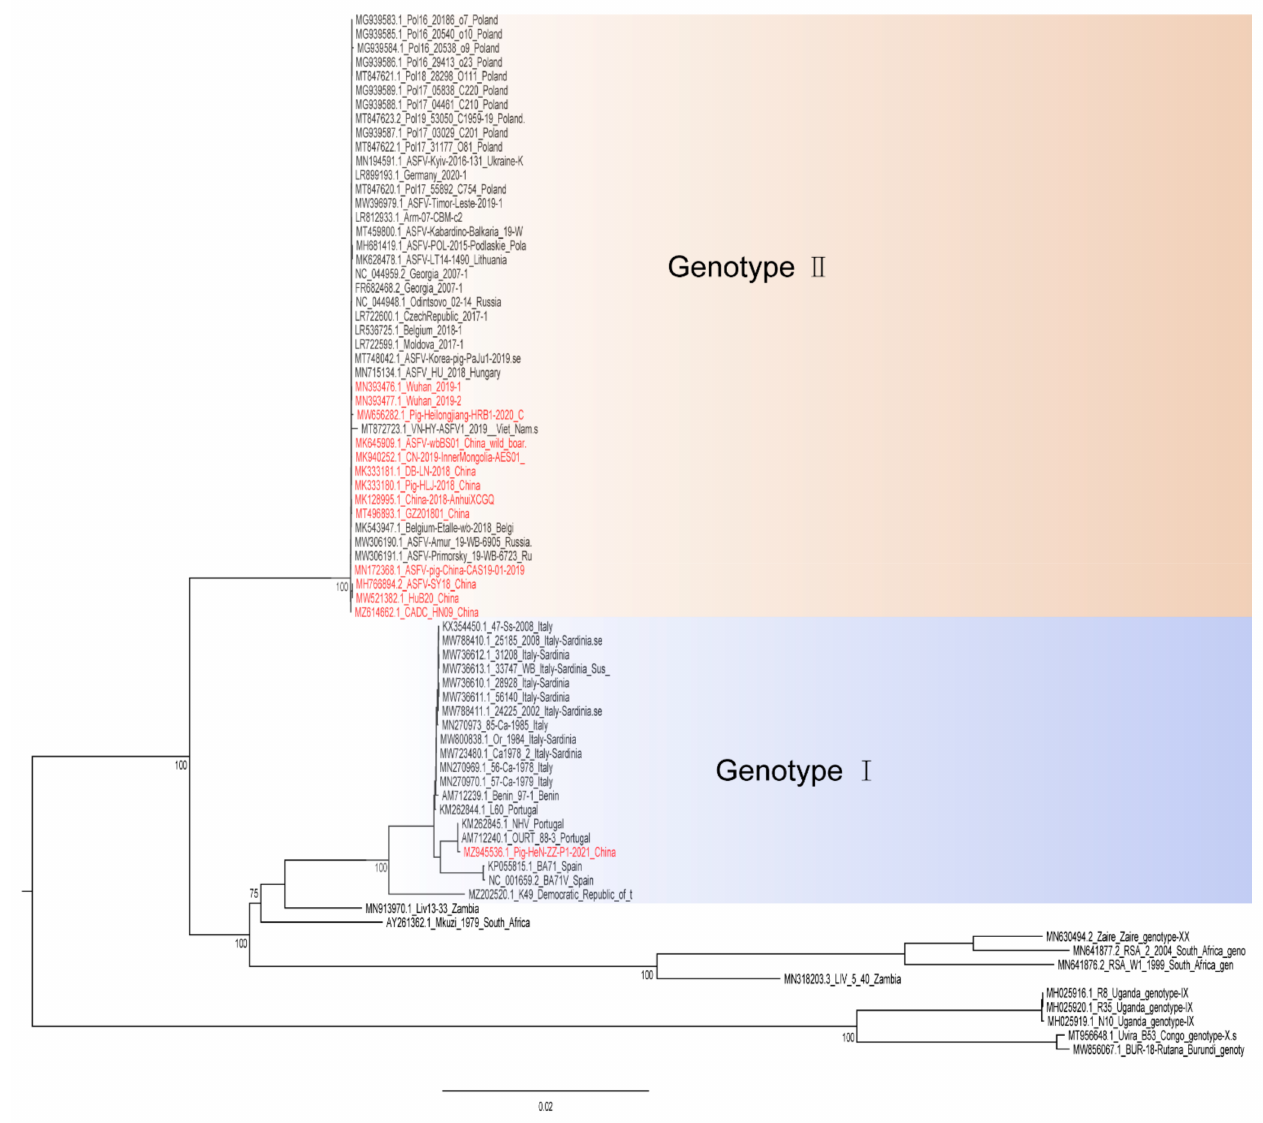
Figure 1. A phylogenetic tree was constructed based on the whole genome sequences of 74 strains in the GenBank database, after which datasets for the sequences were aligned using MAFFT (version 7.149) program [32]. Maximum likelihood (ML) phylogenies for the codon alignment of the genome sequences were estimated using the GTRGAMMA nucleotide substitution model in the IQ-TREE 1.68 software [33]. Node support was determined by nonparametric bootstrapping with 1000 replicates, and the phylogenetic tree was visualized in the Figtree (version 1.4.3) program (http://tree.bio.ed.ac. uk/software/Figtree/) (accessed on 18 January 2022). Types written in red indicate Chinese